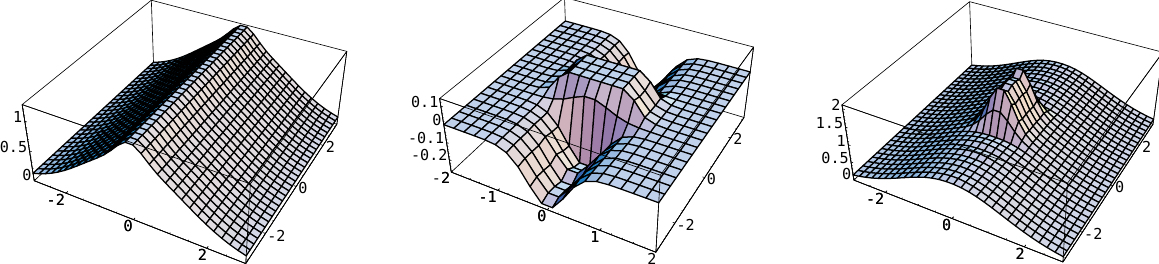
FIG. 36. (Color) Phase space distributions. Left to right: distribution c 0 with ridge; inverted square-wave c 1 ; c 0 1 c 1 has a hot spot.